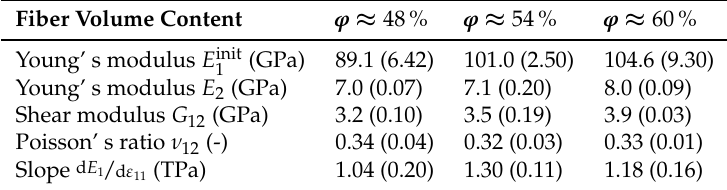
Figure 7. Reference samples—transverse stiffness E 2 ( a ) and shear modulus G 12 ( b ) vs. the fiber volume content. Table 8. Reference samples—material stiffness properties at different fiber volume content values (median values and interquartile range (IQR) in